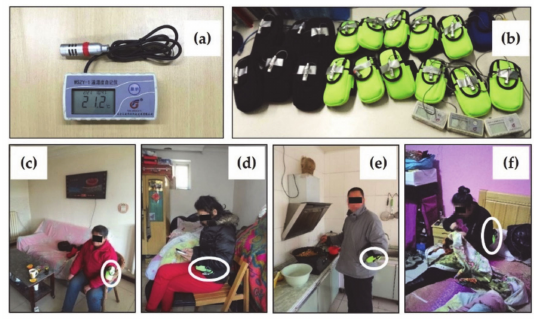
Figure 2. Personal experienced temperature monitoring devices. ( a ) Temperature logger and ( b ) devices used for monitoring. The three on the lower right were not placed in armband sleeves. ( c ) A volunteer wearing a device and sitting in the living room while watching TV. ( d ) A volunteer wearing a device and sitting in the bedroom playing with her smartphone. ( e ) A volunteer wearing a device and standing in the kitchen to cook. ( f ) A volunteer wearing a device and sitting in the bedroom to sew a quilt. The monitoring devices in ( c – f ) are circled with white